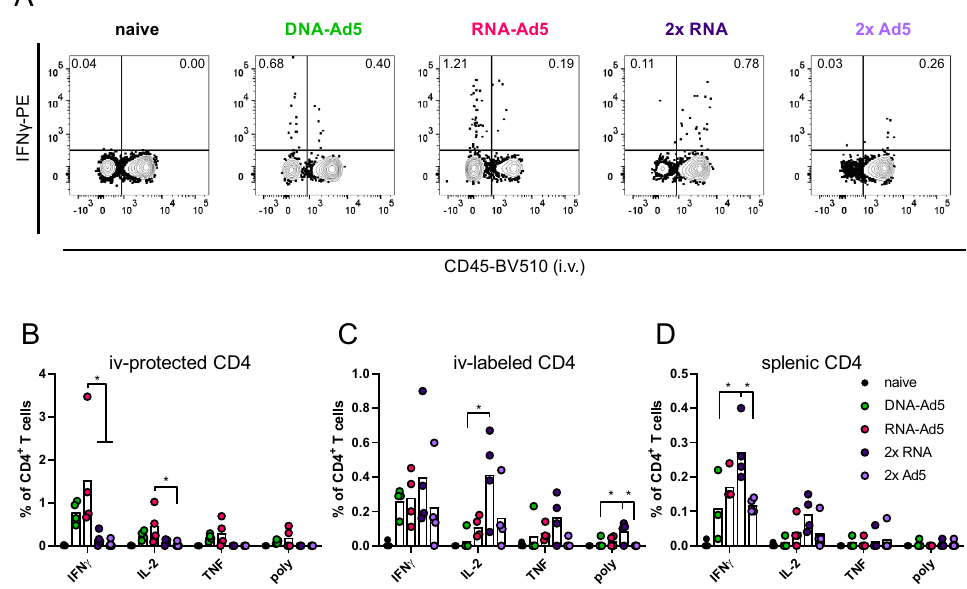
Fig. 9 Spike-speci fi c CD4 + T cell responses. C57BL/6 mice were vaccinated according to Fig. 5A. Lung ( B and C ) and spleen homogenates ( D ) were restimulated with a peptide pool covering major parts of S. The responding CD4 + T cells were identi fi ed by intracellular staining for accumulated cytokines. A Representative contour plots showing IFN γ production in iv + and iv − lung CD4 + T cells. The gating strategy is shown in Supplementary Fig. 3. Bars represent group means overlaid with individual data points; all groups n = 4 (exception: n = 3 for DNA-Ad5 in D ). Data were analysed by one-way ANOVA followed by Tukey ’ s multiple comparison test. Statistically signi fi cant differences are indicated only among the different vaccine groups; p values indicate signi fi cant differences (* p < 0.05; ** p < 0.005; *** p < 0.0005; **** p < 0.0001). poly; polyfunctional T cell population positive for all assessed markers. Representative data from one out of three independent experiments with slightly different end time points are